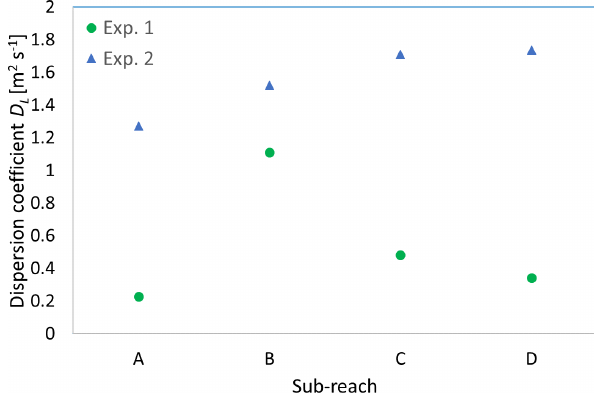
Figure 11. Longitudinal dispersion coefficient ( D L ) in vege- tated (Exp. 1) and fully cut (Exp. 2) conditions for each individual